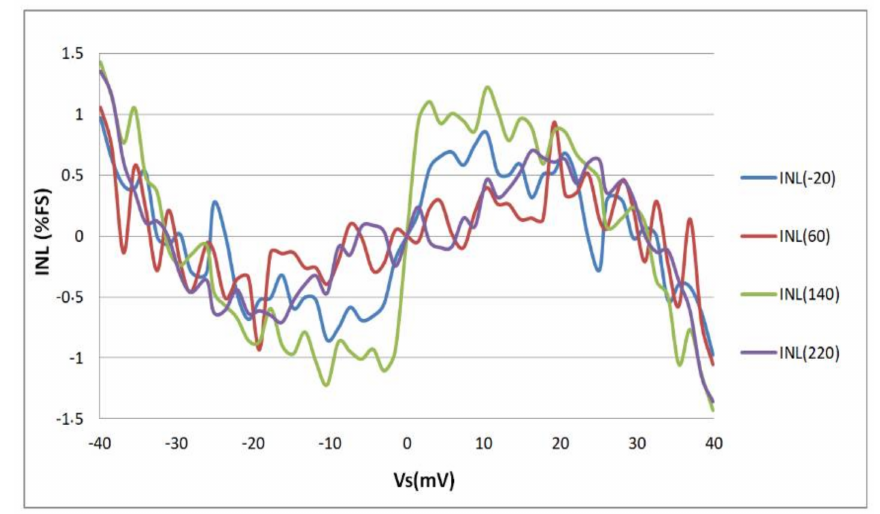
Figure 20. Measured integral non-linearity (INL) over a ± 40 mV input dynamic